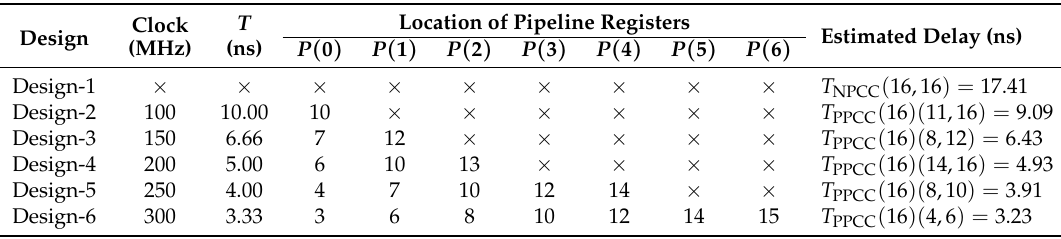
Table 2. Design examples of a cascaded CORDIC obtained using the TSMC 90 nm standard CMOS library ( N = L =